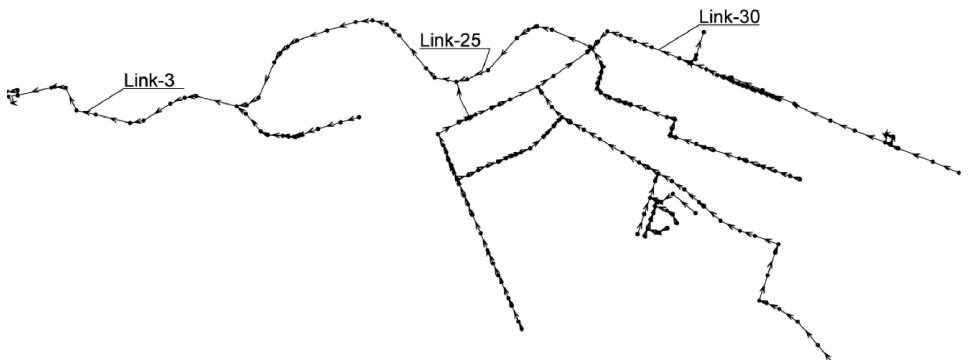
Figure 4. Diagram of modernized stormwater drainage system with the analysed sections marked